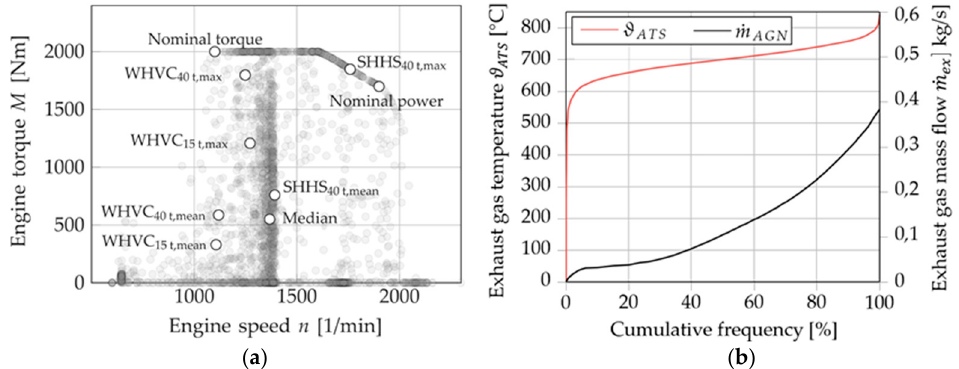
Figure 9. Overview of results of the potential analysis of the natural gas HDV. ( a ) Engine torque over speed. ( b ) Exhaust gas enthalpy analysis.